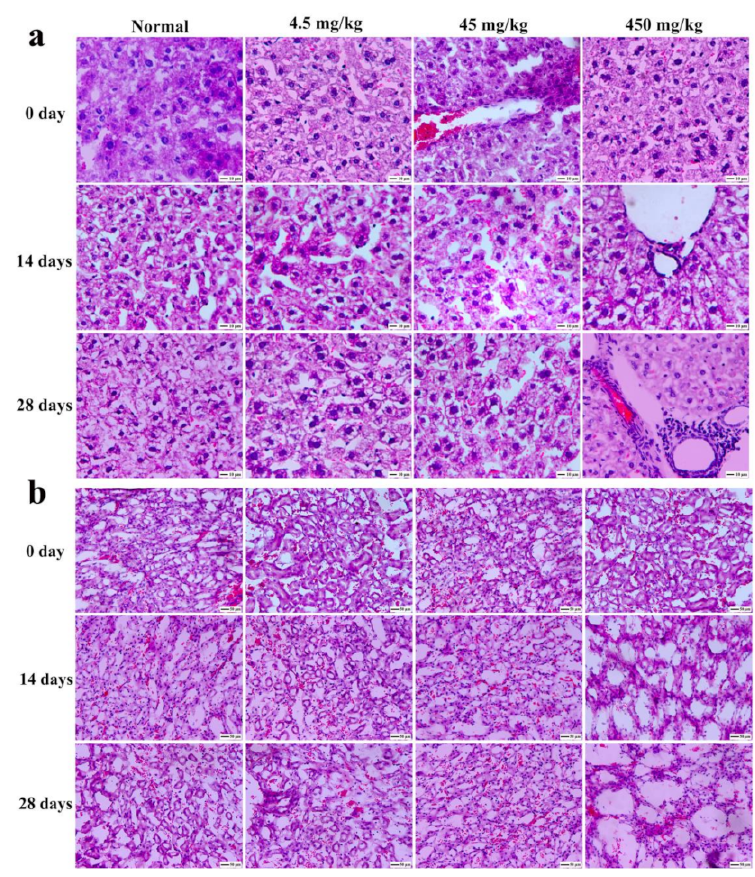
Figure 10. Physiological section of lung from mice of the Fe 2 O 3 /Fe 3 O 4 heterogeneous nanoparticles ( a ) and control groups ( b ) with different doses (hematoxylin